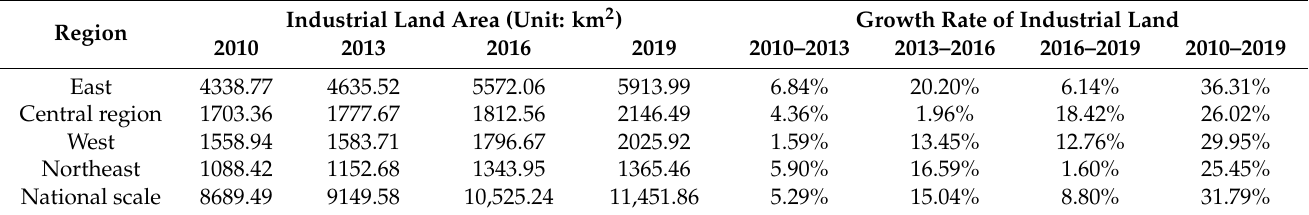
Table 1. Regional difference of area and growth rate of industrial land in China, 2010–2019. Industrial Land Area (Unit: km 2 ) Growth Rate of Industrial Region